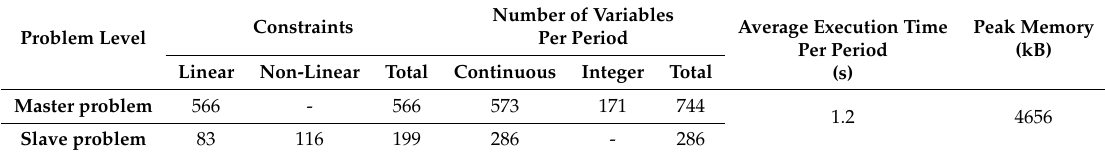
Table 9. Computational execution